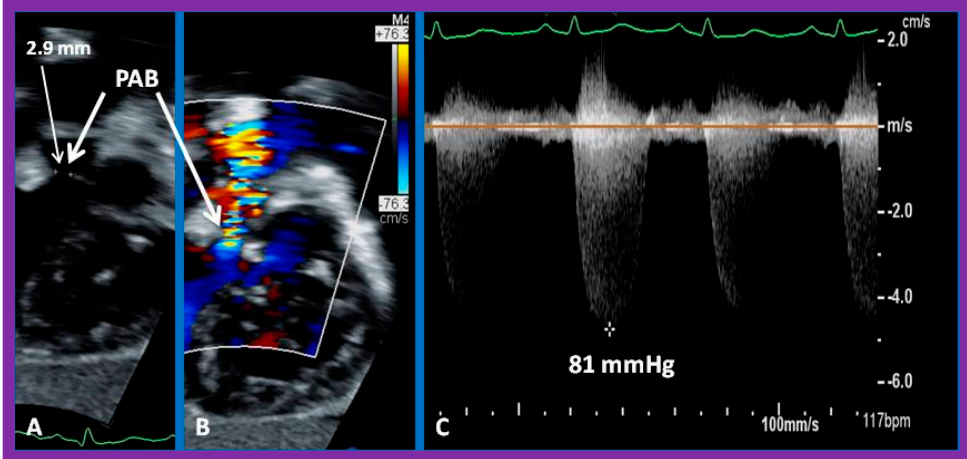
Figure 4. Echo–Doppler recordings demonstrating pulmonary artery banding (PAB) with a narrow two-dimensional width of 2.9 mm ( A ) and by color Doppler imaging ( B ). A significant pressure gradient of 81 mm Hg was recorded by CW Doppler ( C ). Reproduced from [21]. Neonates with the total anomalous pulmonary venous return (TAPVR) with an obstruc- tion to the pulmonary venous return should have immediate surgical correction